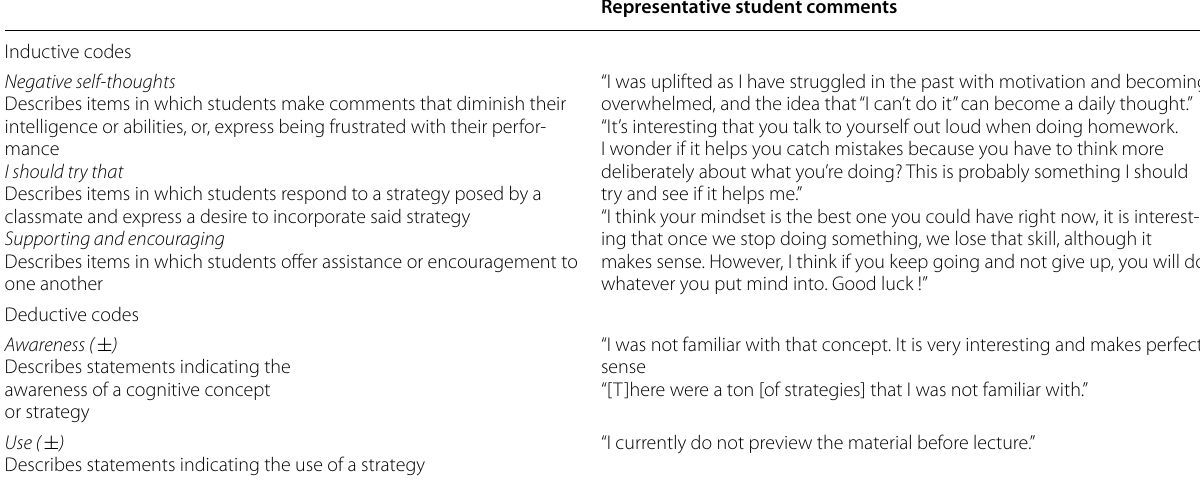
Table 2 Some examples of inductive and deductive codes along with representative statements from